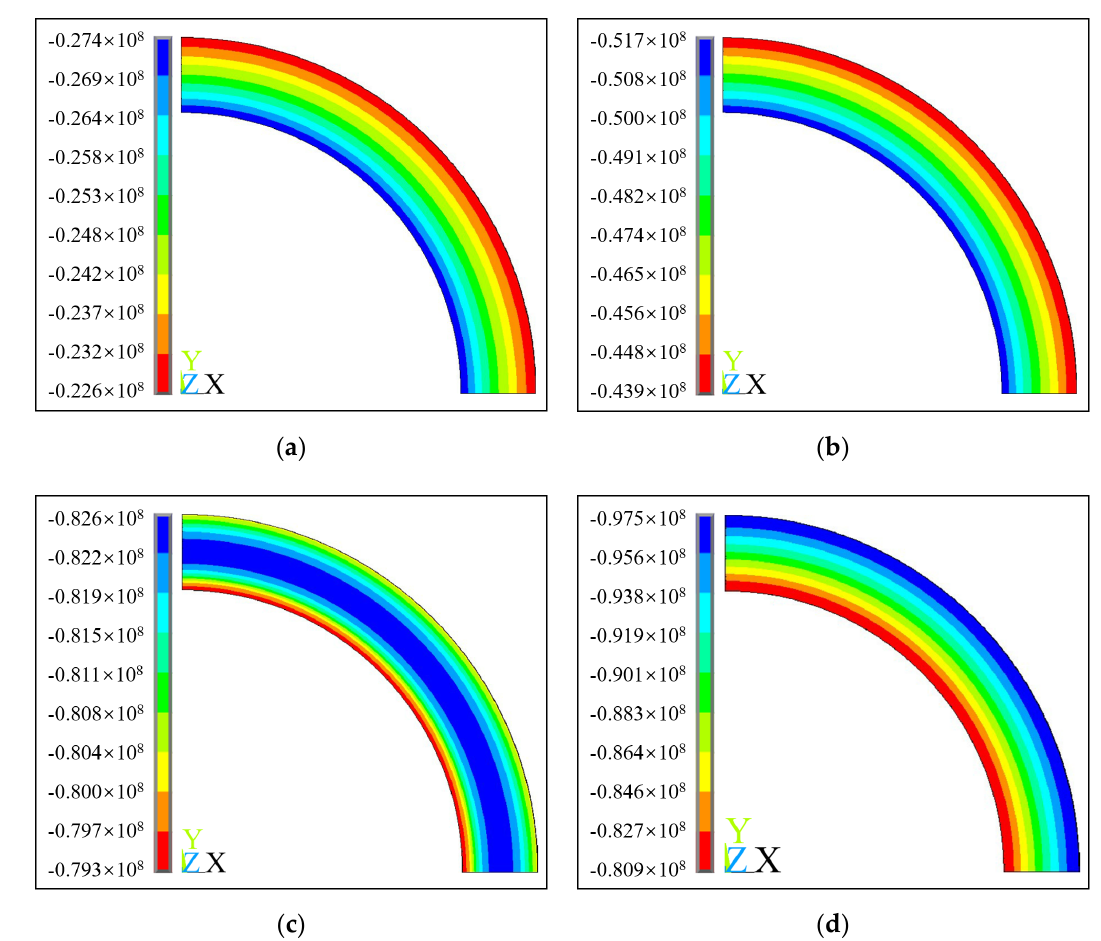
Figure 3. Hoop stress cloud diagrams of D-2 model shaft lining concrete under a surface load: ( a ) 5 MPa; ( b ) 10 MPa; ( c ) 17 MPa; ( d ) 20.9 MPa.